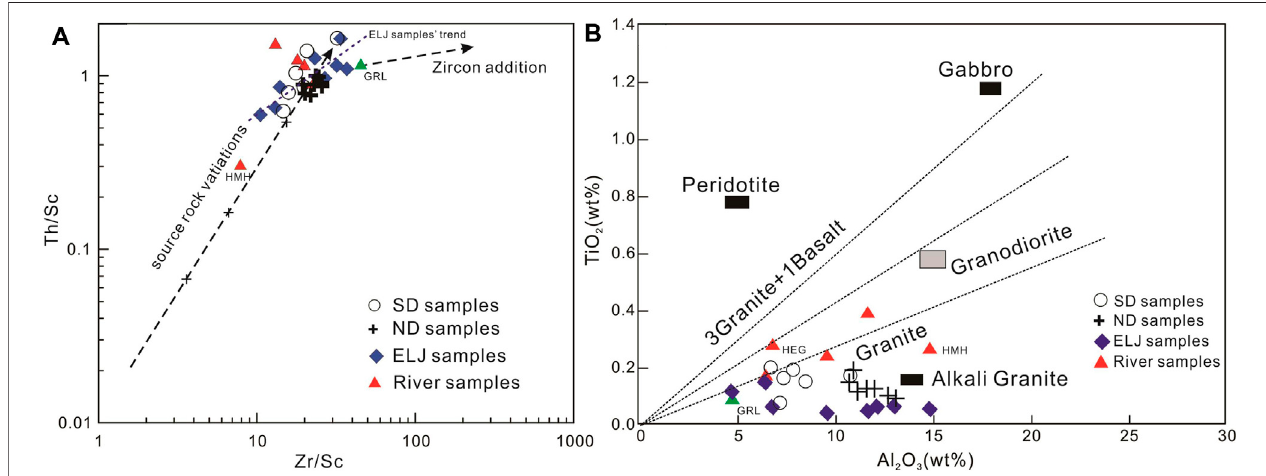
FIGURE 8 | Source rock discrimination plots for the sand sediments. (A) Plot of Zr/Sc versus Th/Sc. ELJ and GRL samples show some recycled detrital materials addition, and most of the source rocks are mainly felsic rock. (B) Plot of Al 2 O 3 versus TiO 2 . The data points re fl ect granites source rocks.